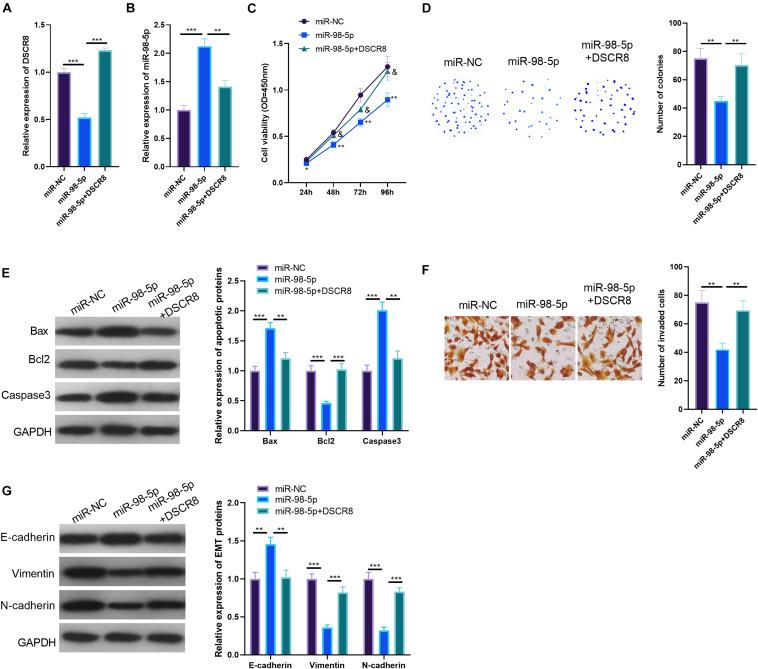
DSCR8 weakened the effects of miR-98-5p. (A,B) RT-PCR was conducted to determine the expression of DSCR8 (A) and miR-98-5p (B). (C) Cell Counting Kit (CCK)8 was performed for cell proliferation detection. *P < 0.05, **P < 0.01 vs. miR-NC group; & represents P < 0.05 vs. miR-98-5p group. (D) Cell growth was further verified by colony formation test. (E) Western blot was used to monitor apoptosis-related proteins (Bax, Bcl2, and Caspase3) expression. (F) Transwell assay was used to detect ovarian cancer (OC) cell invasion. (G) Western blot was used to observe epithelial–mesenchymal transition (EMT) markers (E-cadherin and Vimentin) expressions.**P < 0.01, ***P < 0.001.